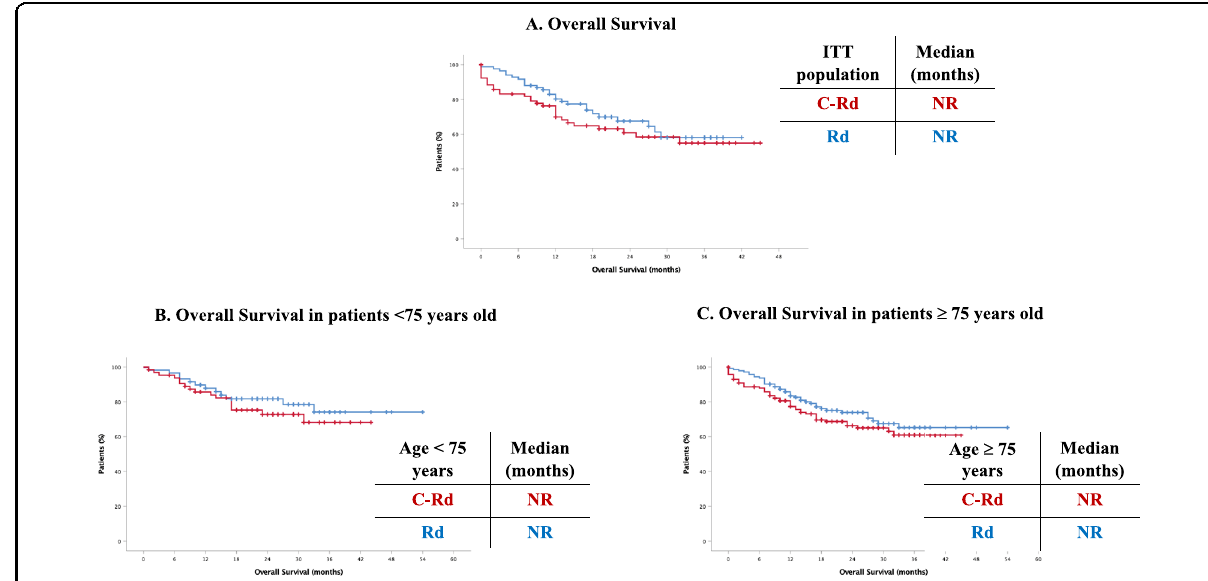
Fig. 3 Overall survival. A In the overall cohort, ( B ) In patients <75 years old, ( C ) In patients ≥ 75 years